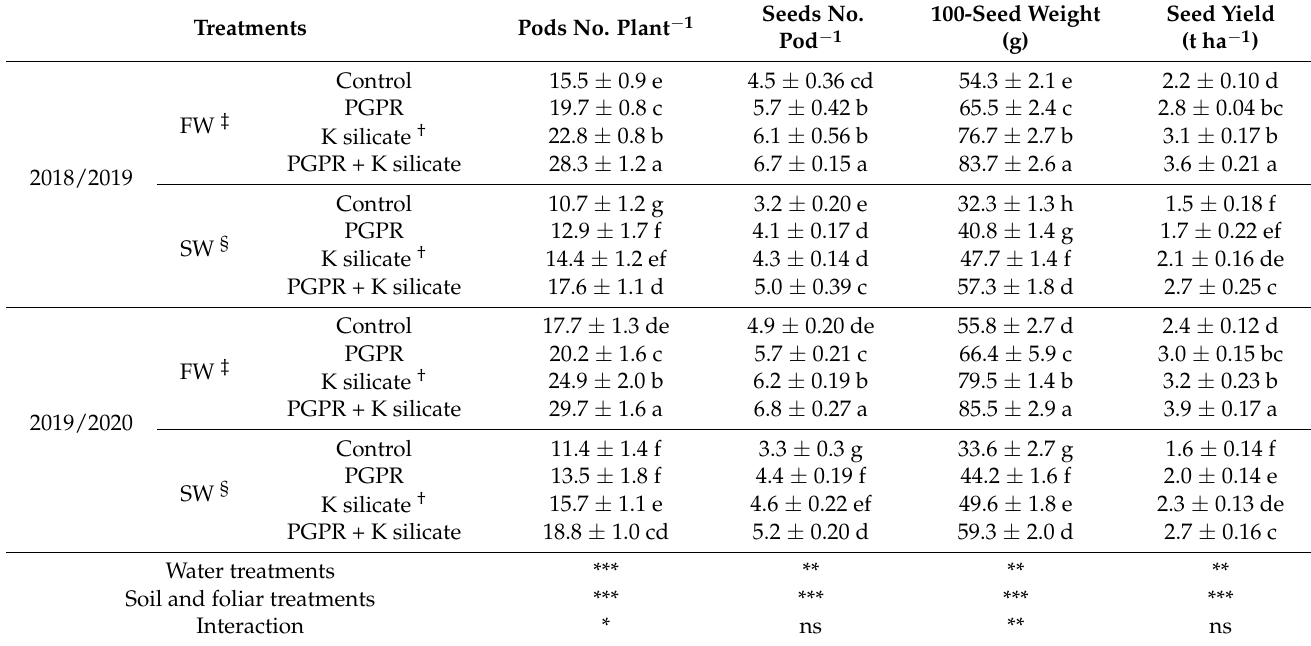
Table 1. Yield and yield-related traits of faba bean plants irrigated with fresh and saline water in salt-affected soil in presence of PGPR and potassium silicate during two growing seasons. Treatments Pods No. Plant − 1